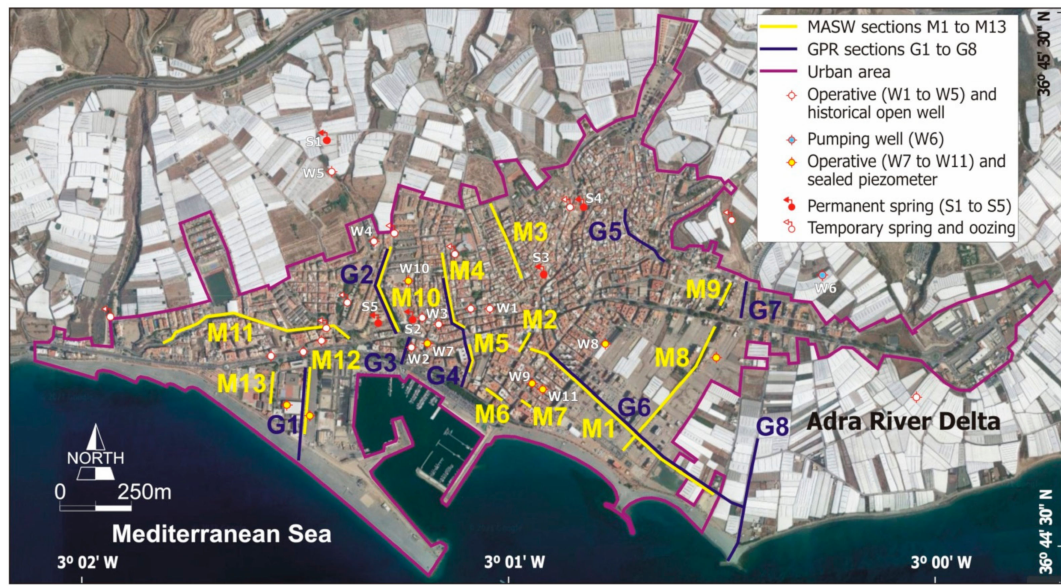
Figure 2. Satellite image of Adra town showing location of the MASW and GPR profiles, and selected groundwater observation